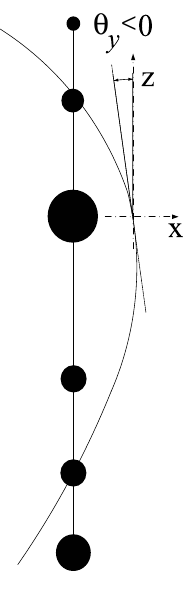
Fig. 8. Deflection angle of Node 3.